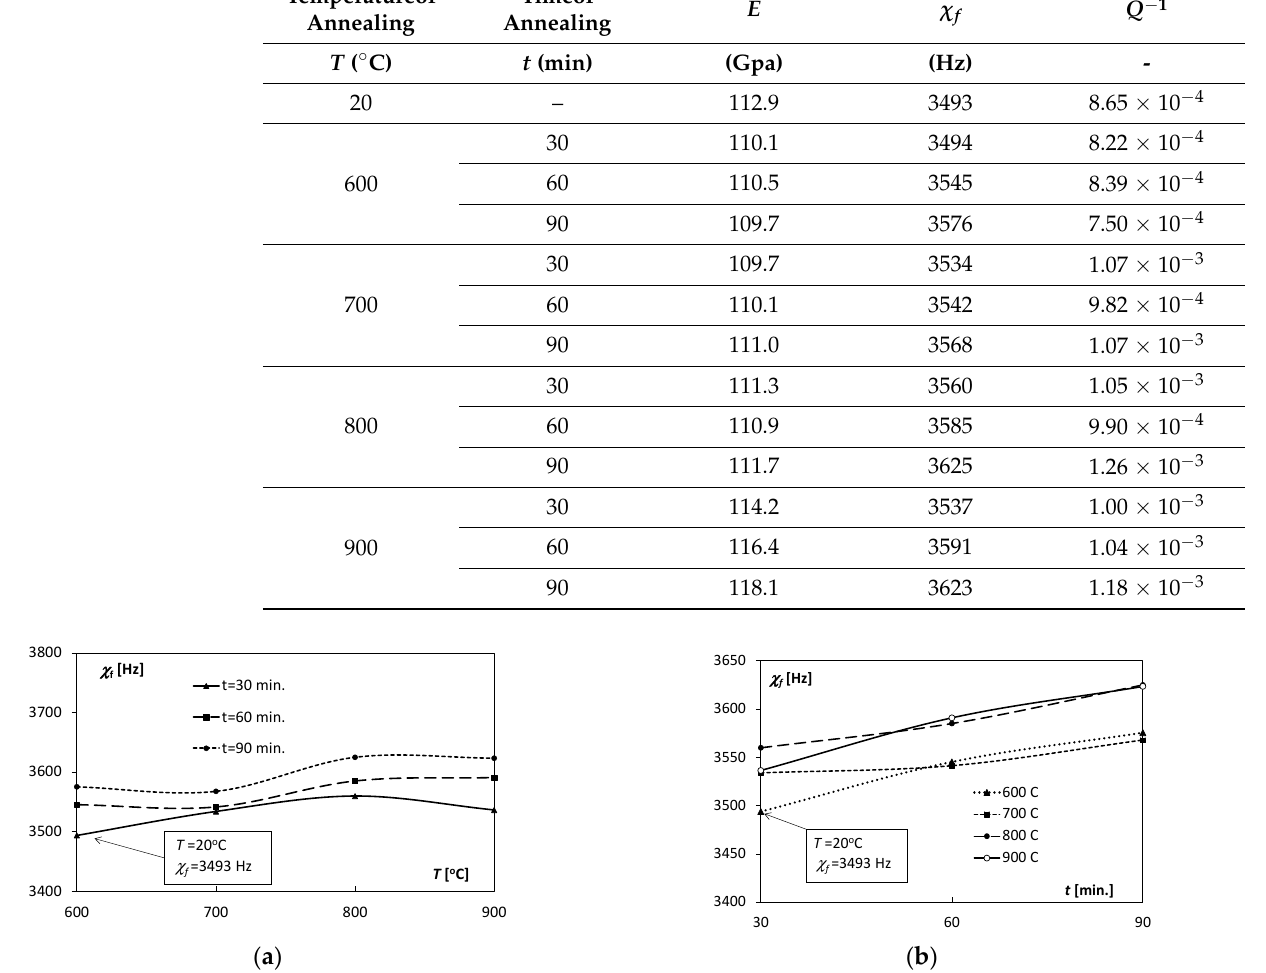
Figure 3. Dependence of the internal friction parameter χ f on: ( a ) temperature T , ( b ) annealing time t .